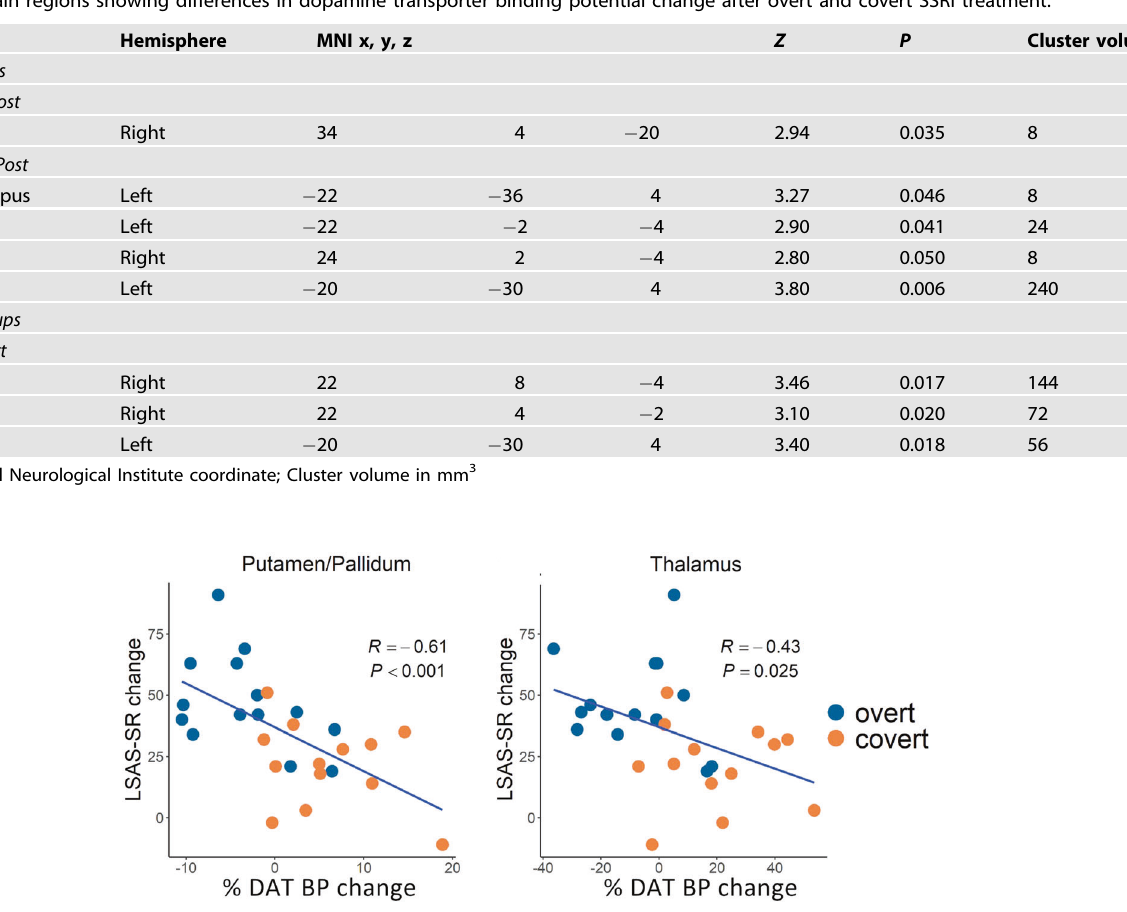
Fig. 2 Brain-behavior correlations. Signi fi cant correlations are shown between decreased dopamine transporter (DAT) availability, expressed as percent pre-post change in binding potential (BP), and symptom improvement expressed as higher scores on the Liebowitz Social Anxiety Scale self-report (LSAS-SR) before as compared to after treatment. Signi fi cant correlations were noted in the right putamen/pallidum cluster (left panel) and in the left thalamus (right panel). BP ND in the bilateral pallidum, left thalamus and left hippocampus in the covert group (Table 1). Between-group differences in the right amygdala (MNI x,y,z: 24,2, − 12, P = 0.017, Z = 2.11, 280 mm 3 ), and left hippocampus (MNI x,y,z: 18, − 30, − 4, P = 0.009, Z = 2.34, 32 mm 3 ) were signi fi cant at an uncorrected statistical threshold, with relatively higher increases in binding in the covert group. fi cant ND within each treatment group, as well as signi group differences in these correlations, are listed in Table 2. Signi fi cant group differences were noted in the bilateral pallidum, left putamen and right thalamus (Fig. 3). Level of SERT occupancy correlated with decreased DAT BP ND in the overt group and increased DAT BP ND in the covert SSRI group. To statistically evaluate involvement of SERT-DAT interactions in response expectancies, follow-up logistic regression analyses were con- ducted with transporter changes as independent variables and group (overt/covert) as dependent variable. These con fi rmed that inclusion of SERT×DAT interaction terms to the models with main effects of SERT and DAT, drastically increased the McFadden R 2 explained variance in all regions (interaction/main effects: puta- men = 0.28/0.02; left pallidum = 0.19/0.03, right thalamus = 0.41/ 0.11), except the right pallidum (0.27/0.27).